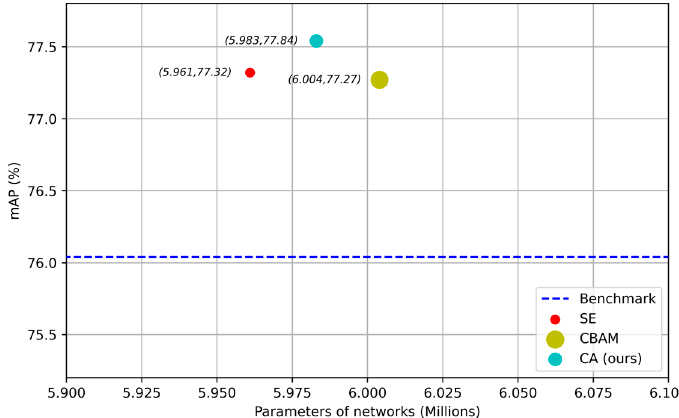
Figure 5. Performance comparison of di ff erent a tt ention mechanisms.